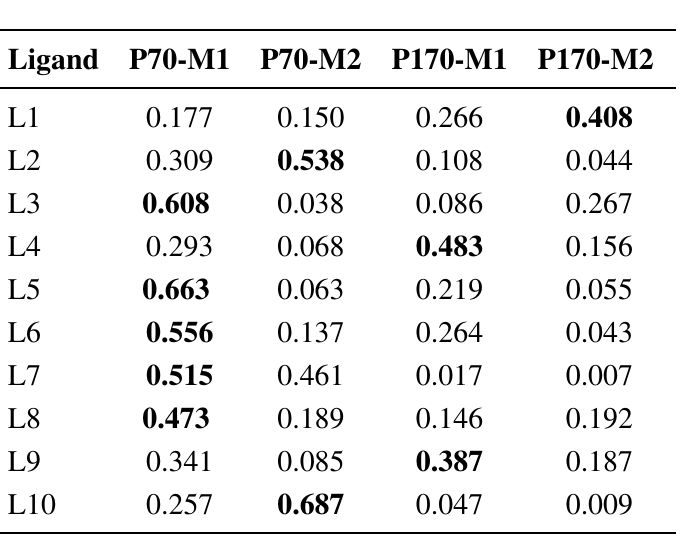
Table 7. Relative weights W of the different simulations i to the binding free energies i calculated for ligands L1-L10 using the S1-S2-A LIE model (as obtained by combining results from all